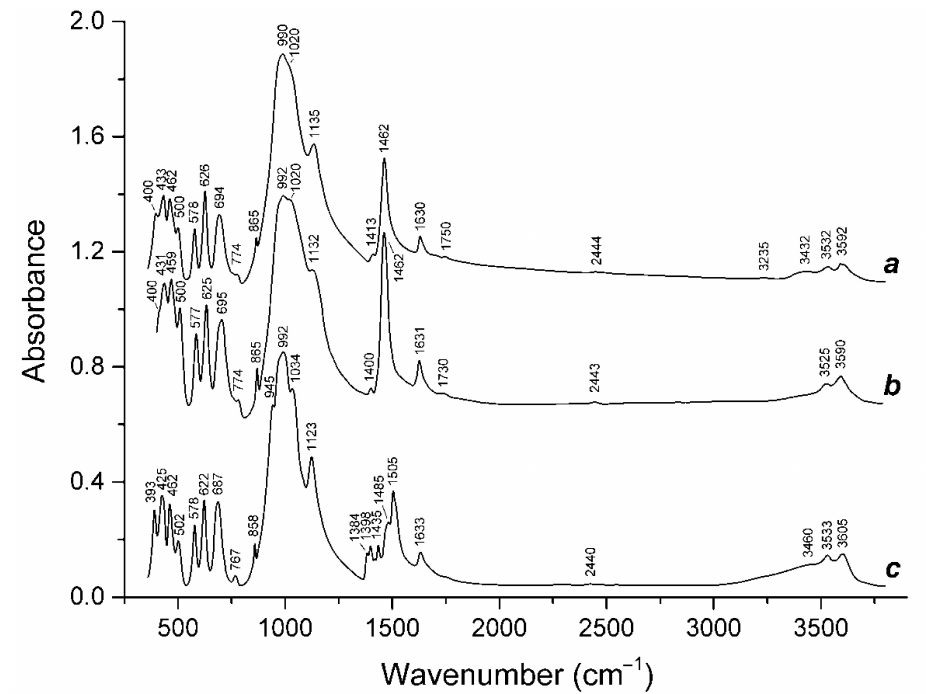
Figure 7. IR spectra of ( a ) S- and P-bearing cancrisilite (Sample 3), ( b ) typical cancrisilite (Sample 4) and ( c ) cancrinite (Sample 1).